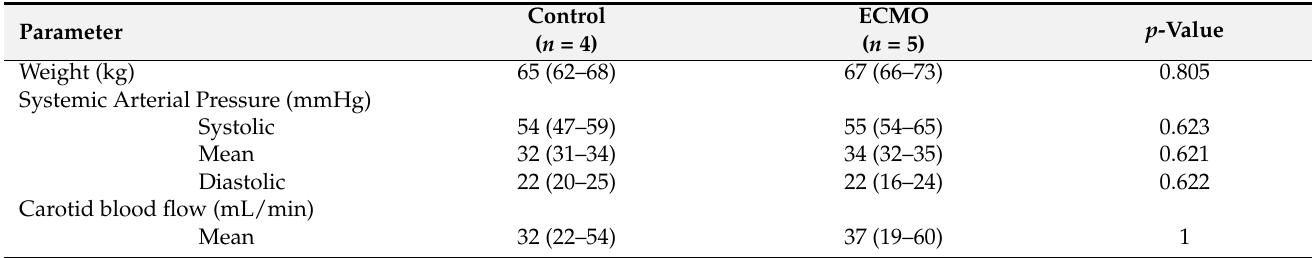
Table 1. Body weight and hemodynamic parameters during cardiopulmonary resuscitation (CPR). Results are presented as median and interquartile range. No significant difference was observed between control and ECMO groups ( p < 0.05).